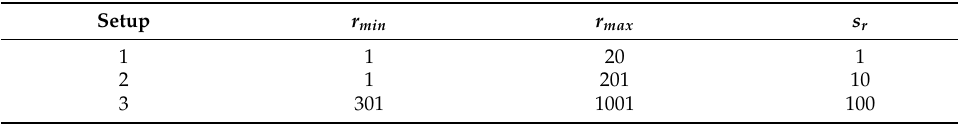
Table 3. Different setups for variation of basis modes.